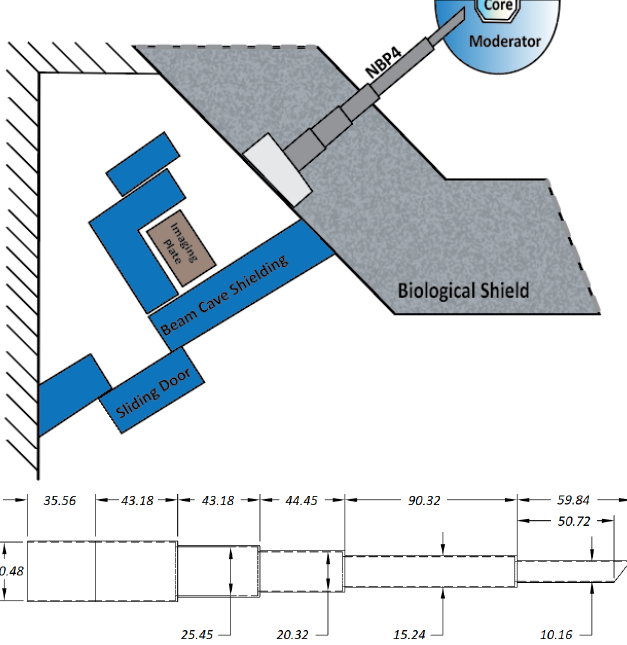
Fig. 1. RSEC NIF layout and the beam port (dimensions are in